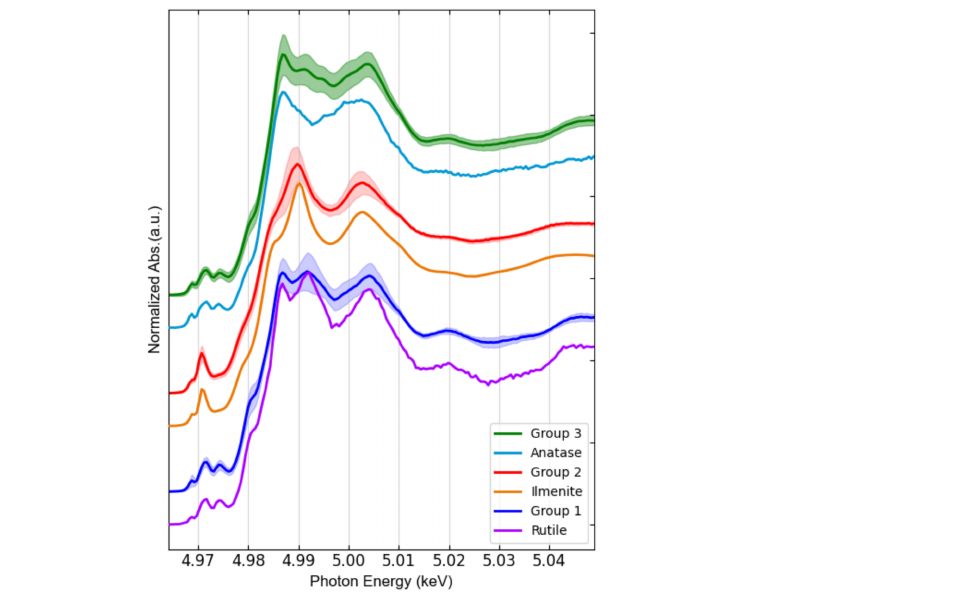
Figure 9. Comparison of the sludge Ti K-edge XANES spectra of three main groups of Ti hotspots identified by PCA, compared to references spectra of TiO 2 phases. Anatase and rutile references were measured at ID21, ESRF. Ilmenite was obtained from XAS database of the beamline 10.3.2 at the Advanced Light Source, Berkeley, CA,